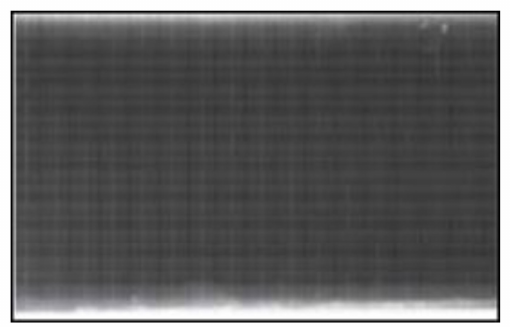
Figure 12. Flow pattern at U oil = 0.324 m / s, U water = 0.081 m / s—experiment